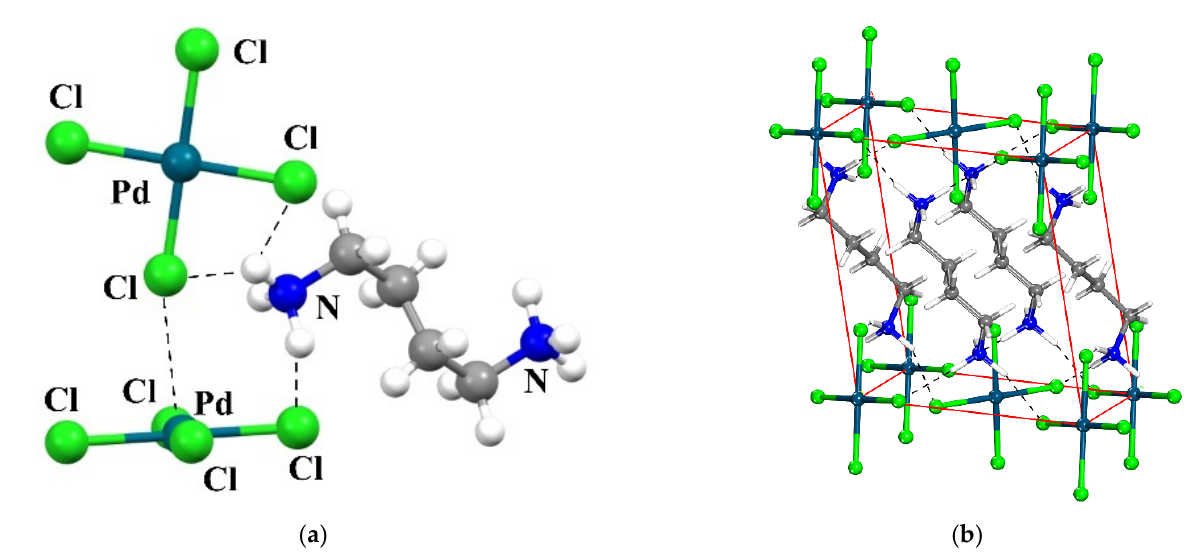
Figure 1. View of the crystal structure of the studied system (CSD REFCODE: NETMOO [84] ). ( a ): View of the PdCl 42 − anions ( b ) View of one unit-cell content showing the layered character of the structure. In both views, the shortest hydrogen bonds are shown as dashed lines.